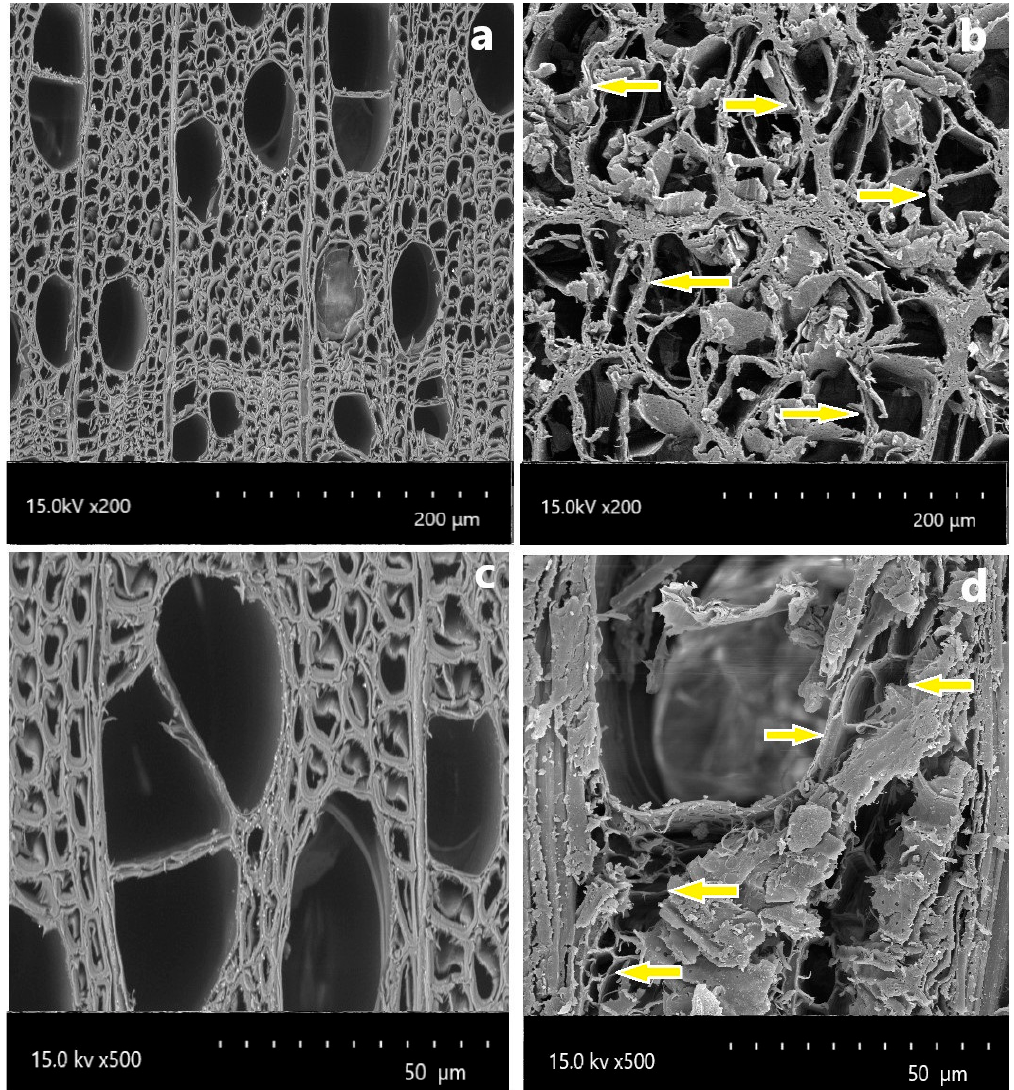
Figure 7. Scanning electron microscopy (SEM) micrographs of fresh and archaeological poplar at 200 μ m ( a and b ), and 50 μ m ( c and d ) magnification. Arrows indicate the damaged parts of AW.